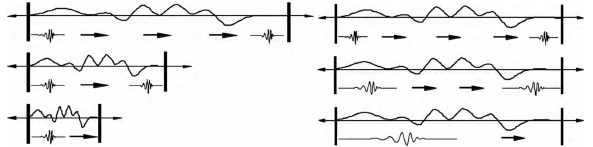
Figure 1. Downsampling the signal in case of DWT (left) and upsampling the wavelet in case of UDWT (right) (Fugal, 2009).